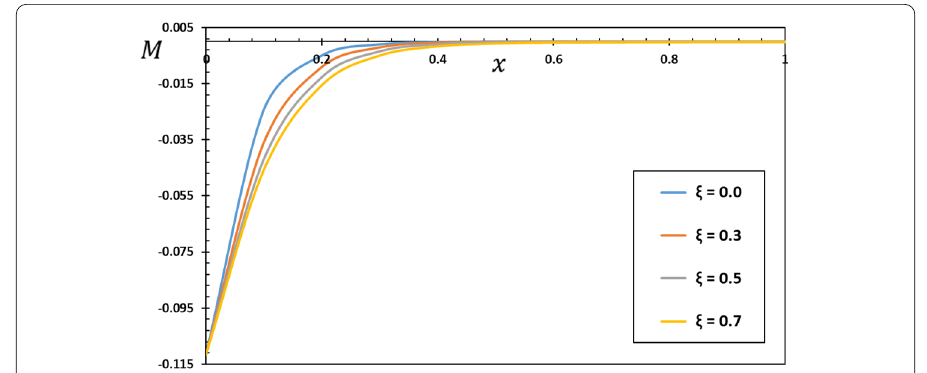
Figure 9 The effect of nonlocality ( ξ ) on the variation of the bending moment M